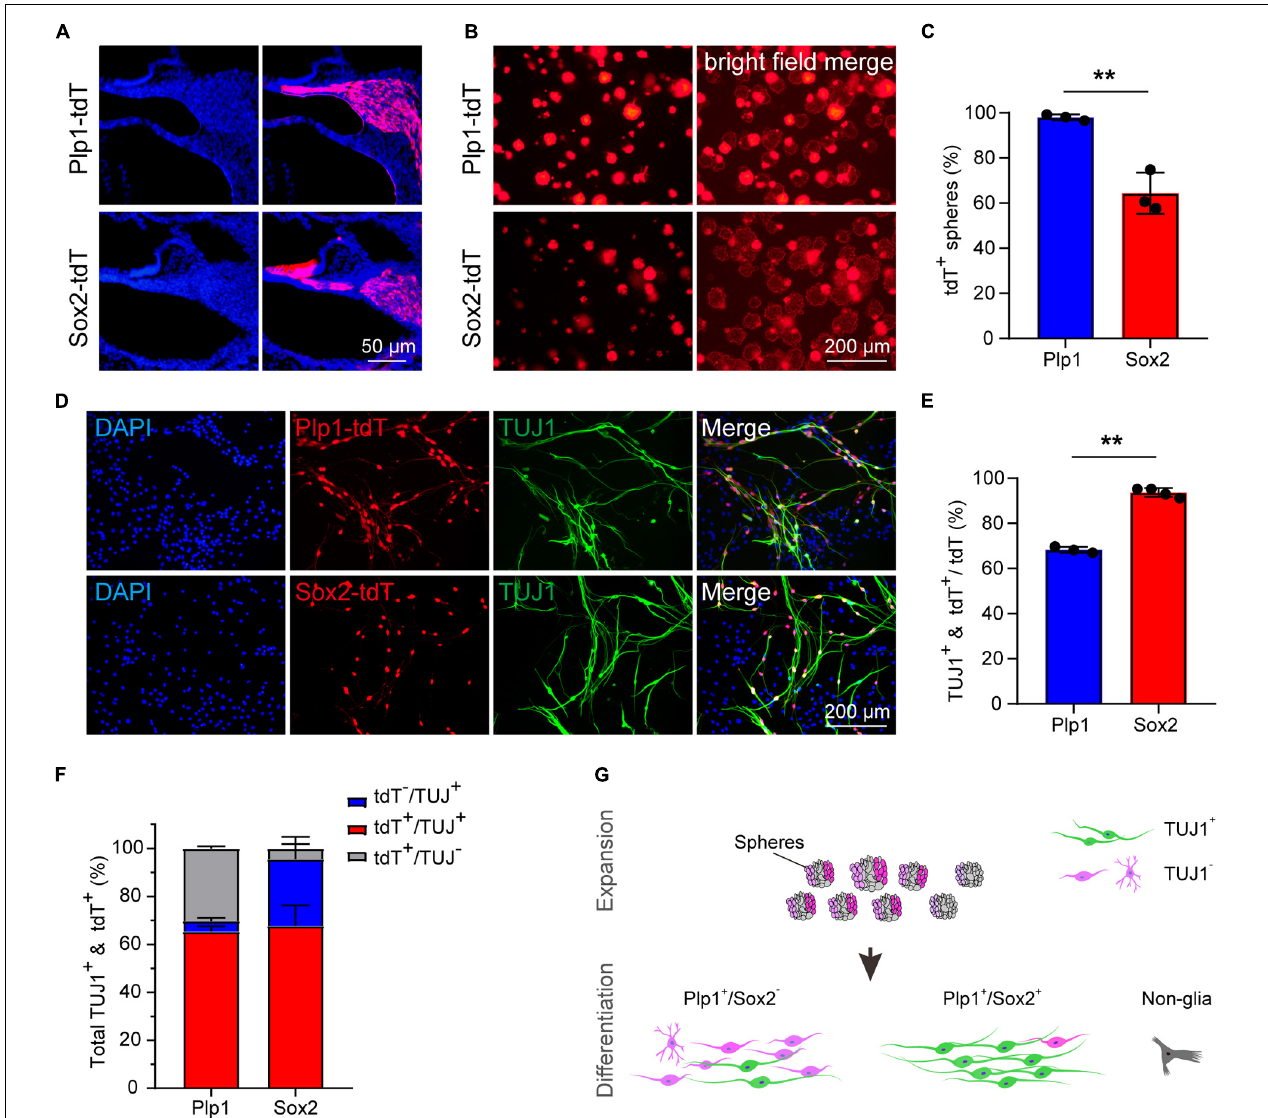
FIGURE 3 | The Sox2 + cochlear glial cells were highly efficient in neuronal differentiation. (A) Distributions of Sox2-tdT and Plp1-tdT positive cochlear glial cells in P4 cochlea. tdTomato expression was induced by tamoxifen from P1 to P3. (B,C) Representative images and quantification of the Sox2-tdT and Plp1-tdT positive spheres at 5 div. N = 3, error bars represent mean ± SD. (D,E) Representative images and ratios of TUJ1 + neurons differentiated from Sox2-tdT and Plp1-tdT positive cells at 8–9 div. N = 3 or 4, error bars represent mean ± SD. Data from 3 to 4 independent experiments. (F) Percentages of TUJ1 + neurons derived from Sox2-tdT or Plp1-tdT positive cells relative to the total amount of TUJ1 + plus tdT + cells. (G) A model showing Sox2 + glial cells exhibit high potential for neuronal differentiation. ** p < 0.01 by unpaired student’s t -test.